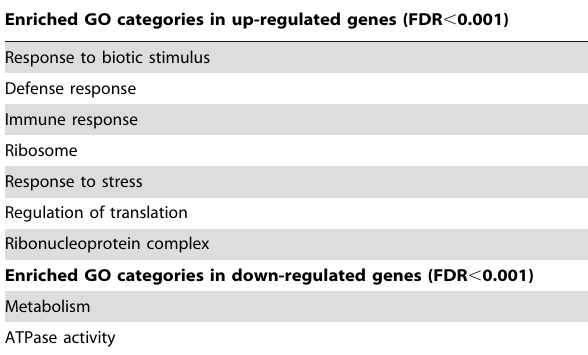
Enriched GO categories in up-regulated genes (FDR ,